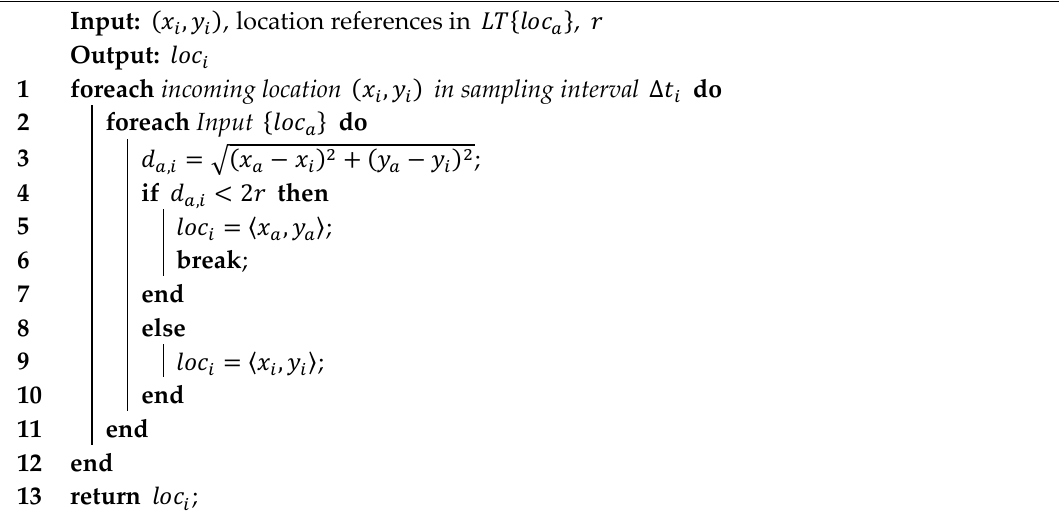
Algorithm 1 The algorithm for recording location information